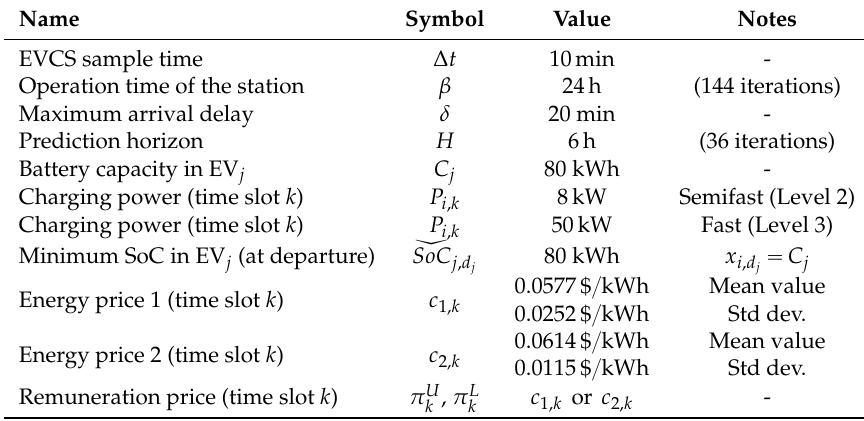
Table 2. Case study simulation parameters.